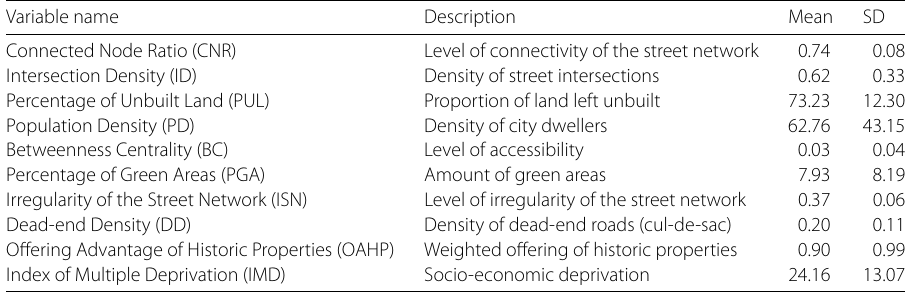
Table 2 Metrics of urban form and IMD with relative descriptions, means, and standard